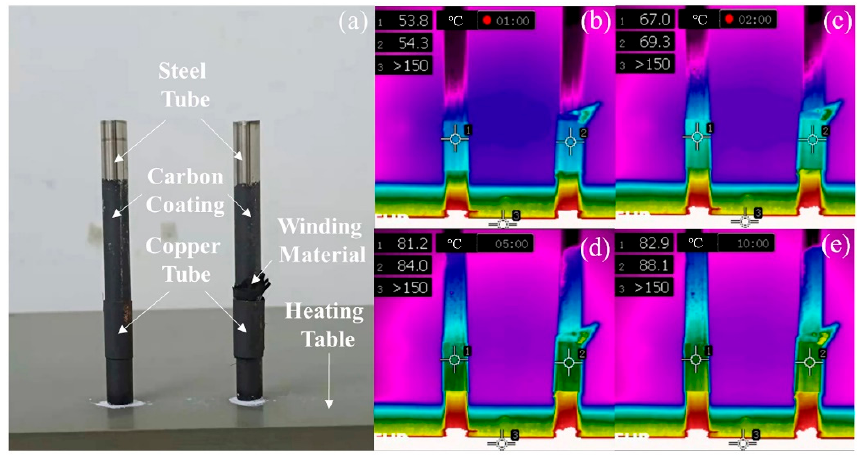
Figure 8. ( a ) Photograph of CFF-G/SPU composite as a winding thermal interface material and temperature distribution after heating for ( b ) 1 min, ( c ) 2 min, ( d ) 5 min and ( e ) 10 min.